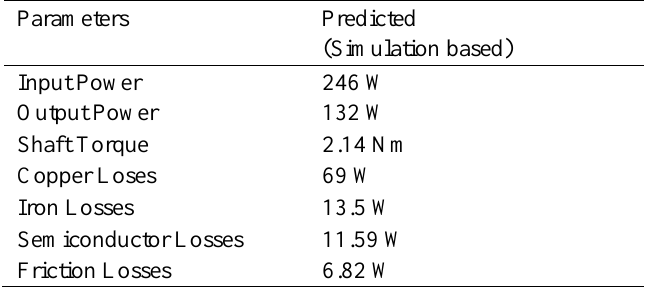
Fig. 14. Predicted losses in single-pulse mode at 25 0 , 30 0 and 31